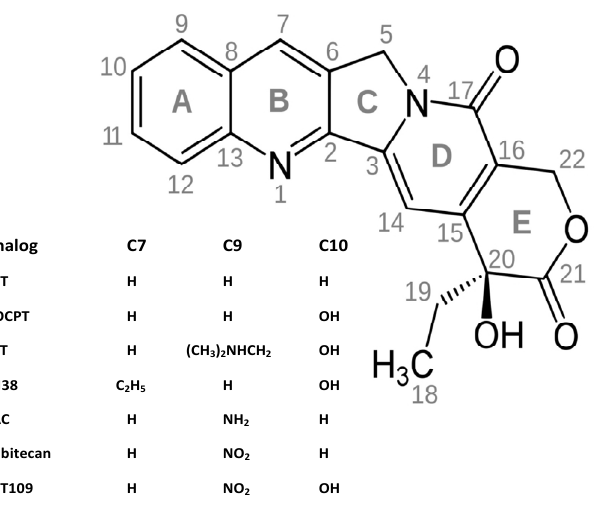
Figure 1. Structure of camptothecins used in the present